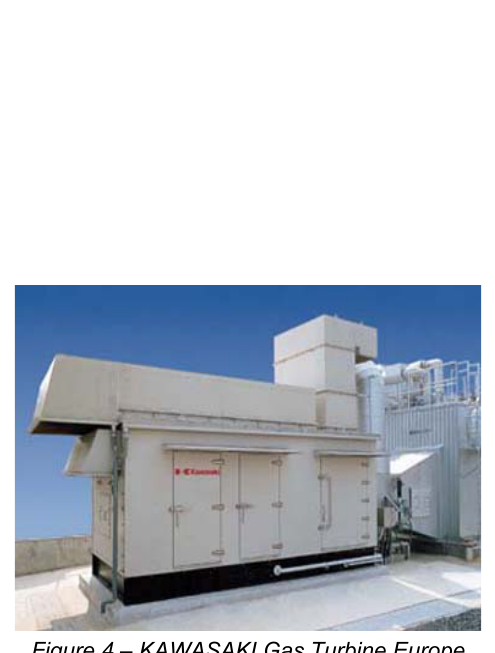
Figure 4 – KAWASAKI Gas Turbine Europe Рис . 4 – KAWASAKI Gas Turbine Europe